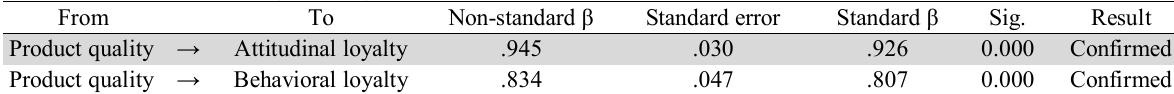
The summary of some basic statistics